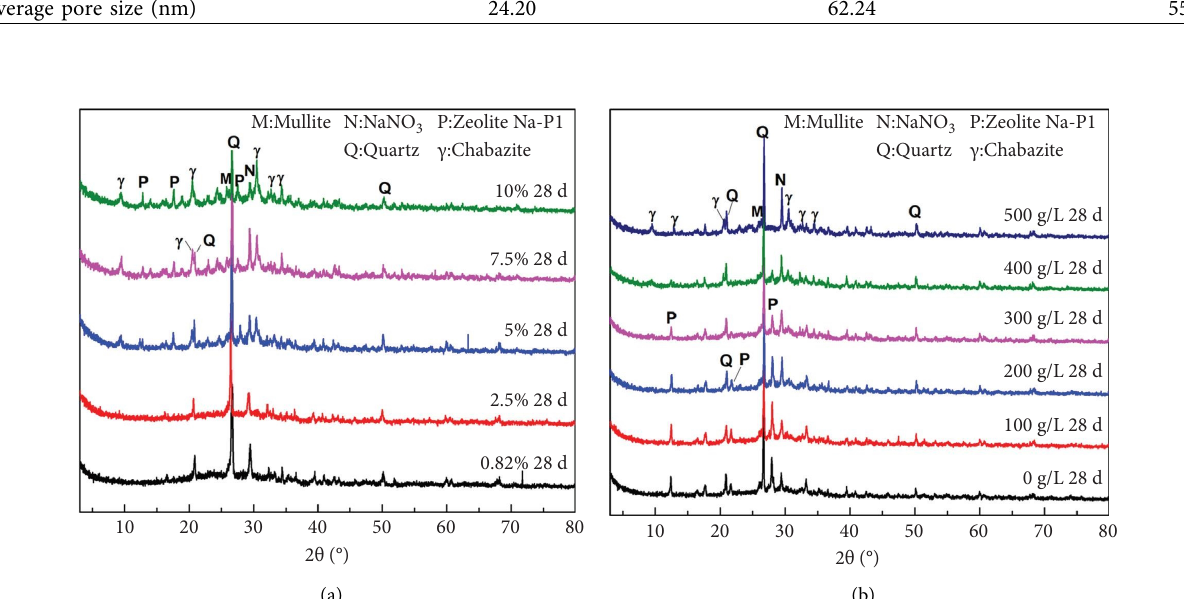
Figure 10: XRD patterns of the SFCM after curing at 90 ° C for 28d. (a) Sodium hydroxide content; (b) sodium nitrate